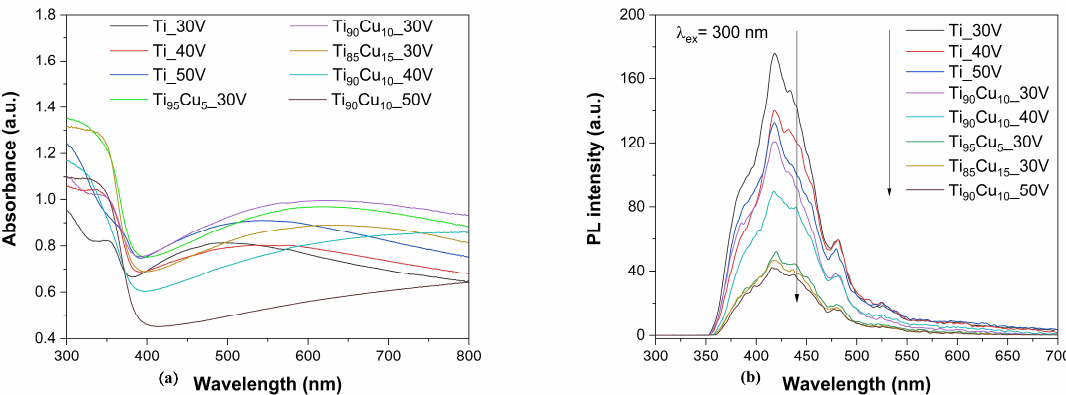
Figure 4. Absorbance ( a ) and photoluminescence ( b ) spectra of pristine TiO 2 and TiO 2 /Cu x O y